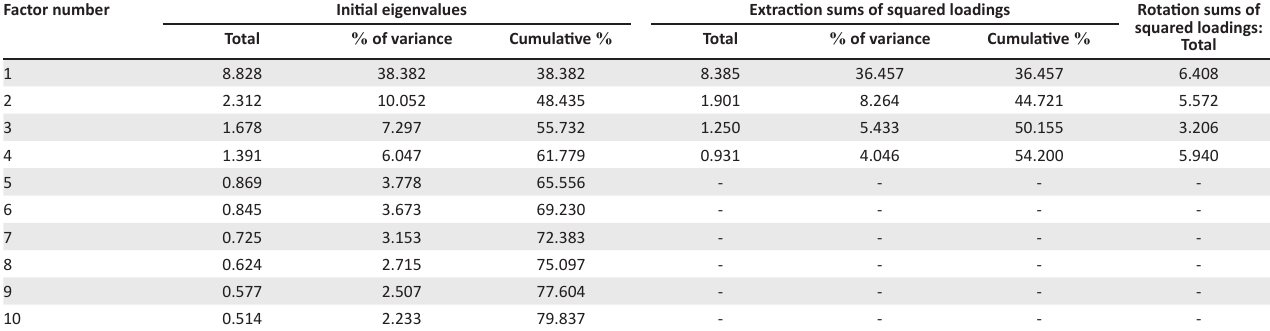
squared loadings: